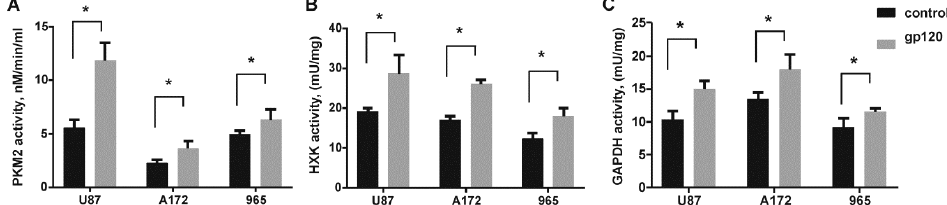
Figure 5. Gp120 increases the activity of glycolytic enzymes in glioma cells. Colorimetric/fluorometric pyruvate kinase ( A ), hexokinase ( B ) and glyceraldehyde 3-phosphate dehydrogenase ( C ) activity assays were performed in untreated U87, A172 and 965 glioma cells and the same cells continuously treated with gp120 for 7–10 days. Kinase activity was calculated as the amount of product (pyruvate, NADPH and NADH respectively) produced in a sample in 10 min. Mean ± S.E. and significant differences between control and gp120 treatment (*) are shown ( p < 0.05). Unpaired t -tests were used statistical analysis.